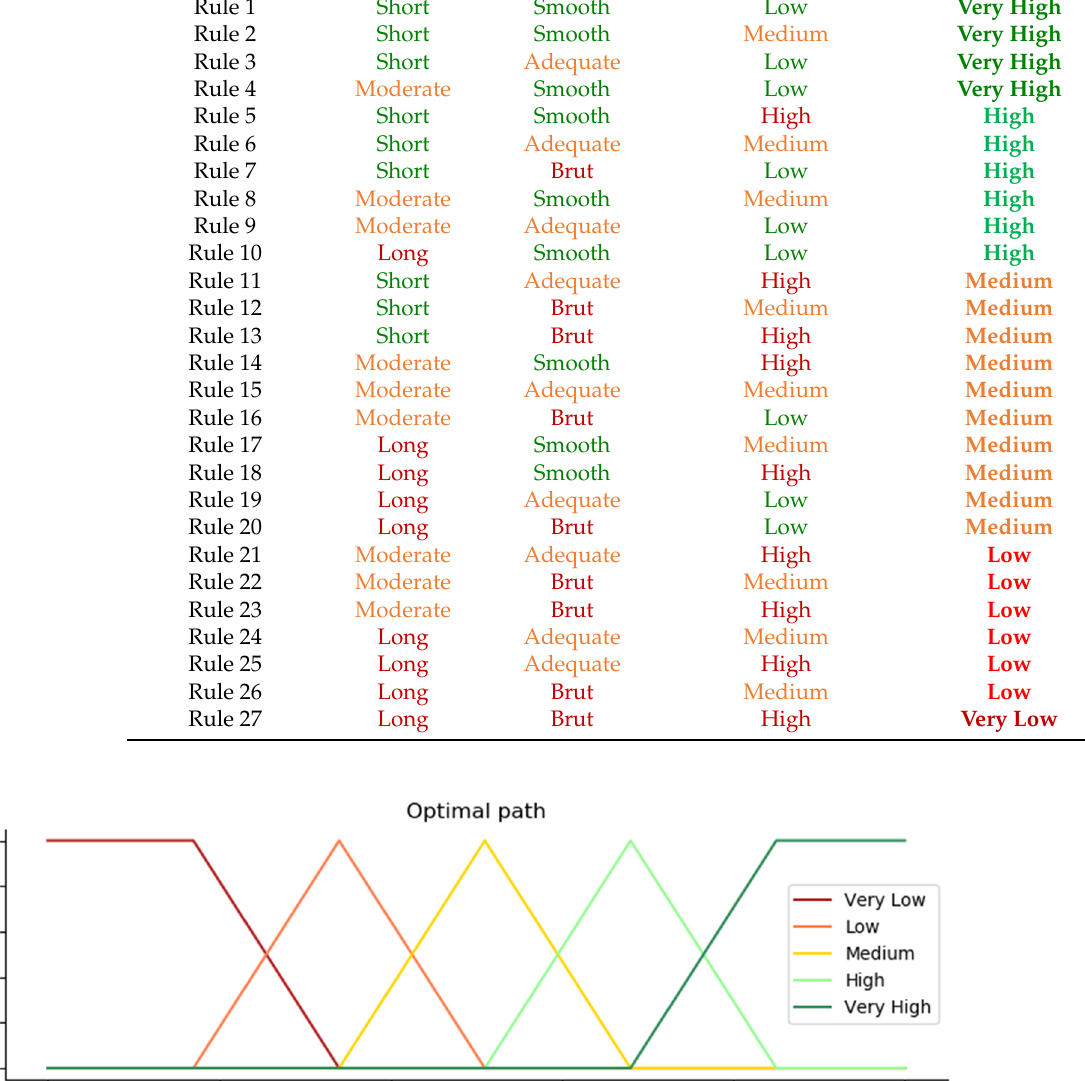
Figure 6. Membership function of the overall quality of the path. Table 1. The fuzzy rules adopted for the FIS.